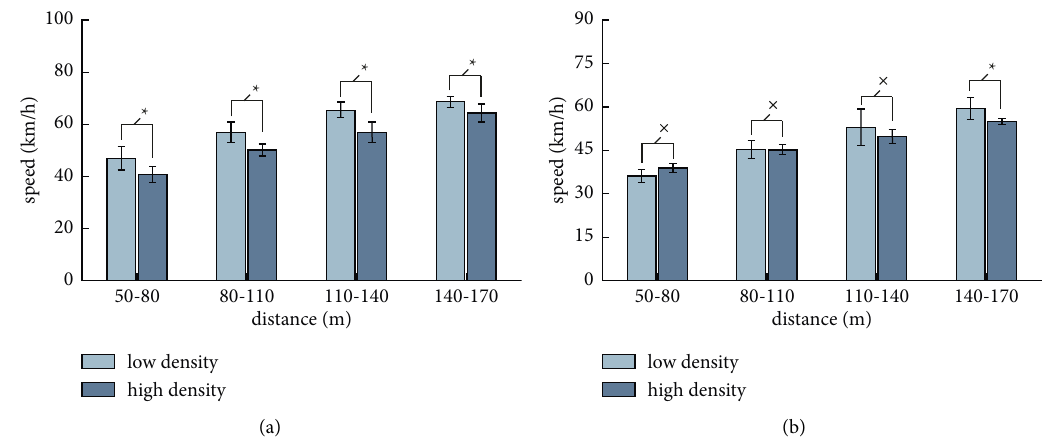
Figure 12: ANOVA results for traffic density on the first approach speed. (a) Freedom; (b) follow.